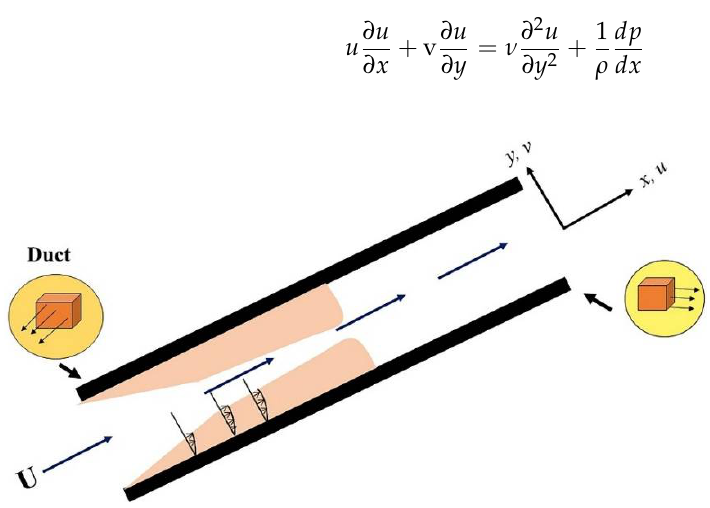
Figure 1. The pictorial representation of flow along with the parallel plates.